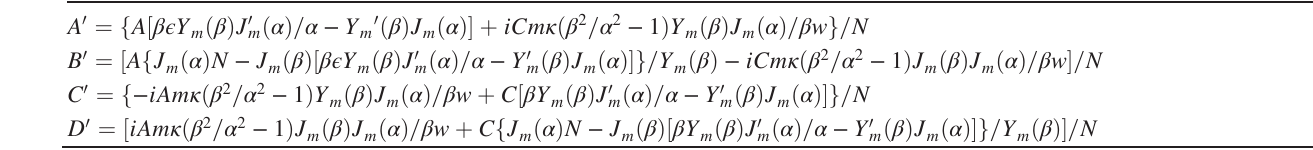
TABLE V. Radiative modes: The radial partial waves of modal fields Eq. (A9) are given by case (1) in Table IV both inside and outside the fiber, with amplitudes listed in this table. Unprimed amplitudes apply inside the fiber, primed amplitudes outside the fiber. The amplitudes A , C ∈ C are independent, and B ¼ D ¼ 0 . We define N ≡ Y Table III.